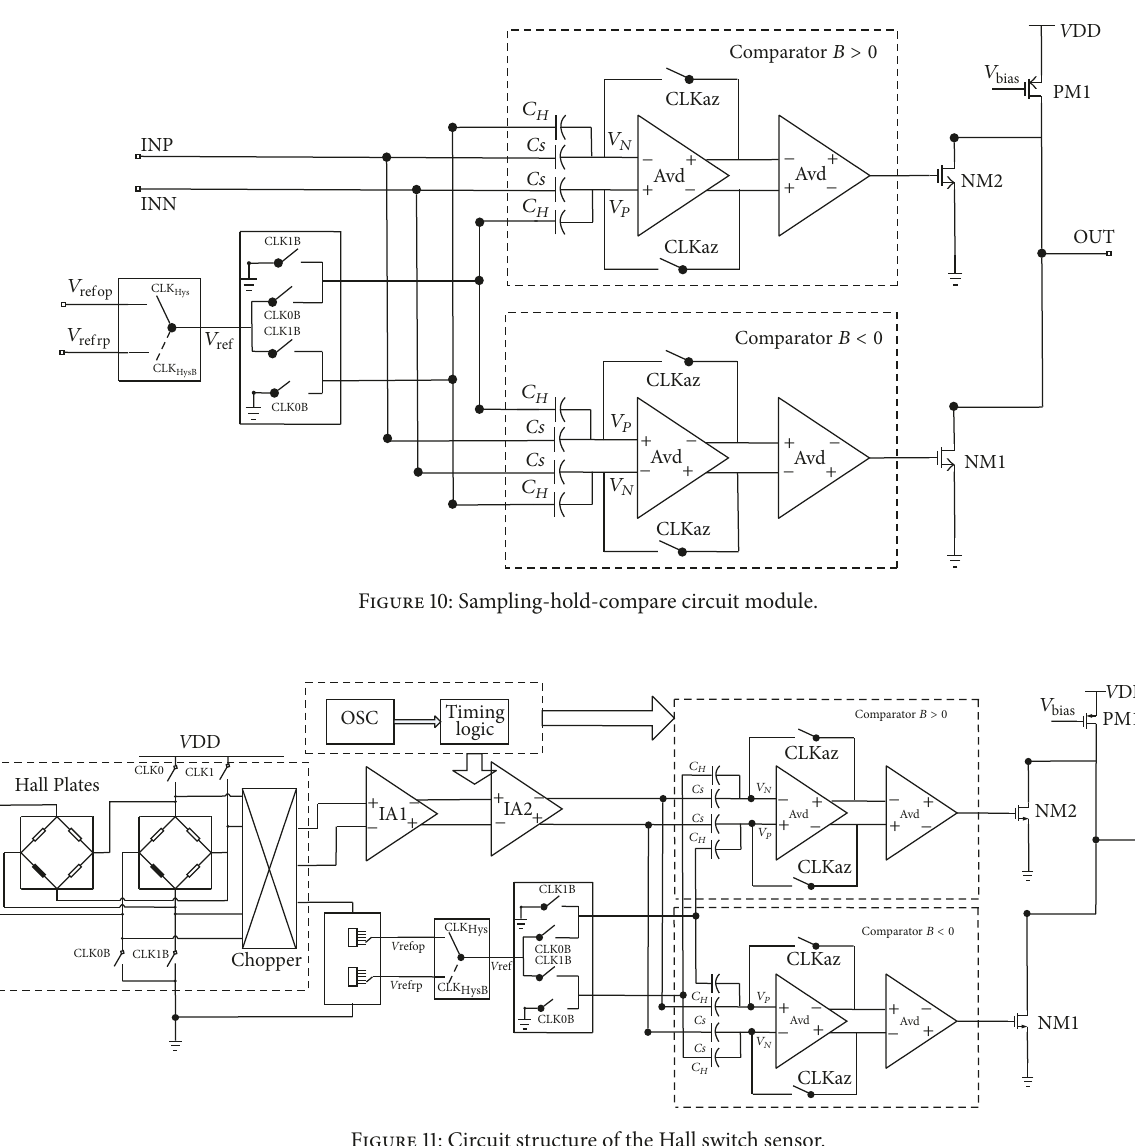
Figure 11: Circuit structure of the Hall switch